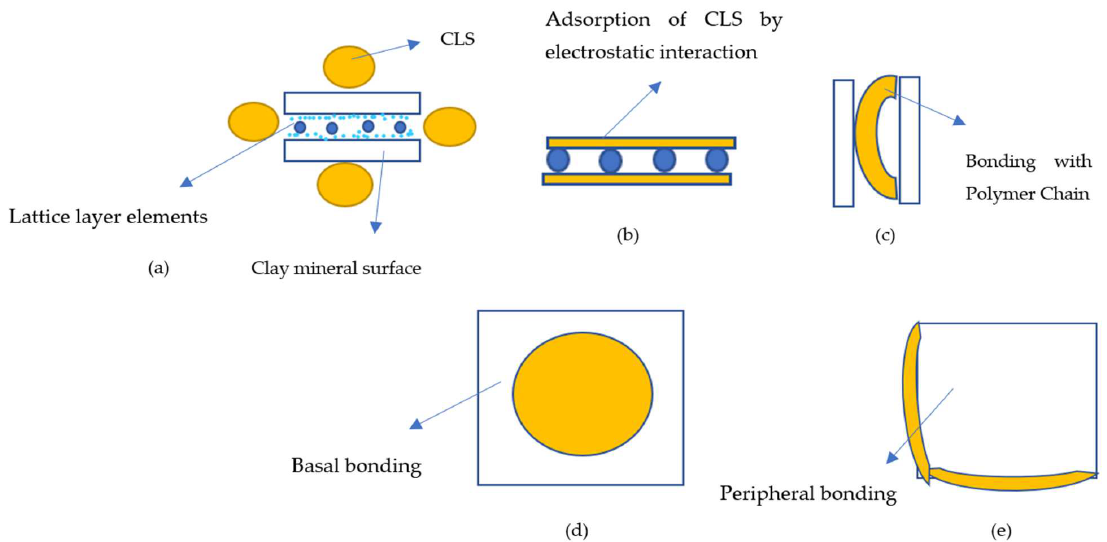
Figure 4. The mechanism behind the strength improvement of clay–GS–CLS mixtures.